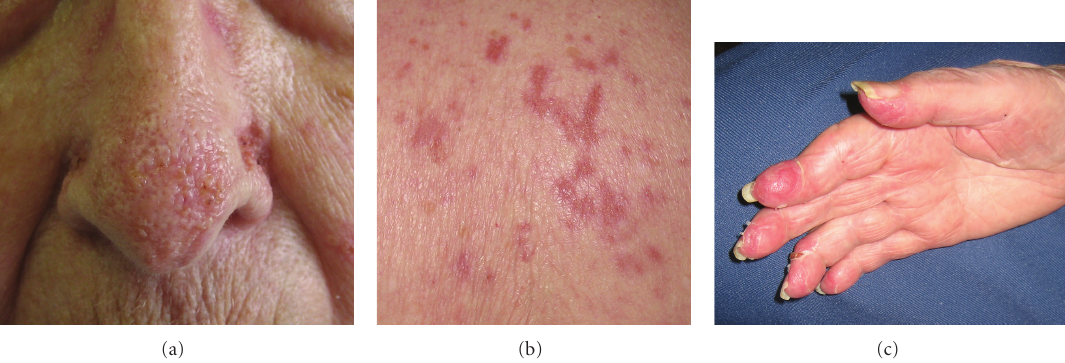
Figure 3: Clearing of a ff ected areas 3 weeks following discharge on tapering dose of